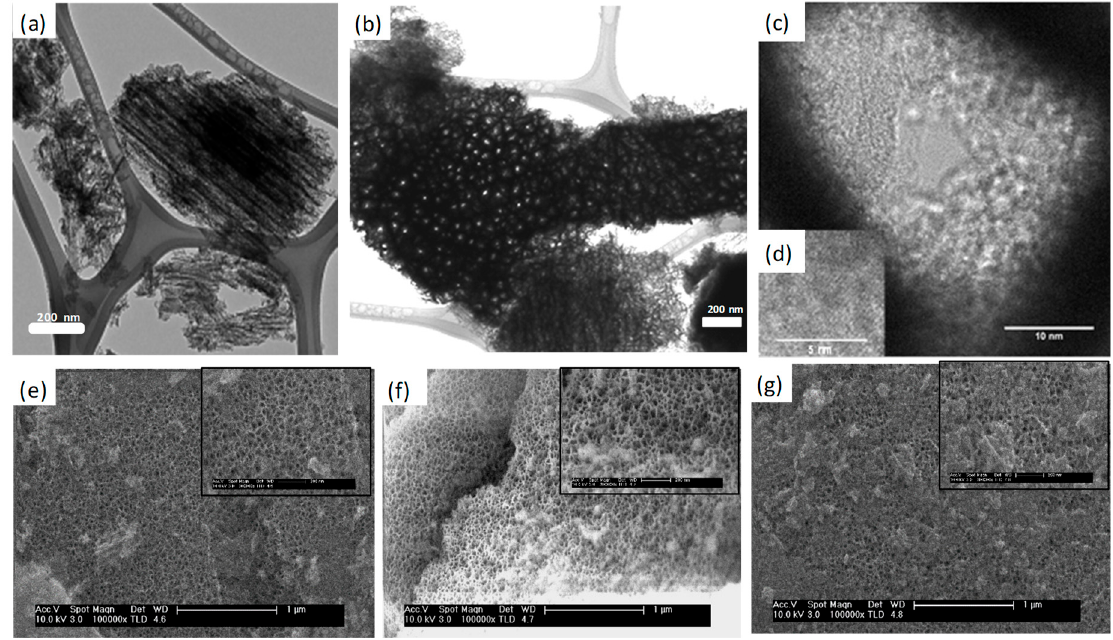
Figure 5. Transmission electron microscopy (TEM) lateral ( a ) and top ( b ) images of columnar PSiPs and ( c ) TEM image of a pore and ( d ) detail of a Si nanocrystal revealing (100) planes. FESEM images of ( e ) the surface of PSiPs, and PSiPs functionalized with ( f ) APTS and ( g ) PFDS.